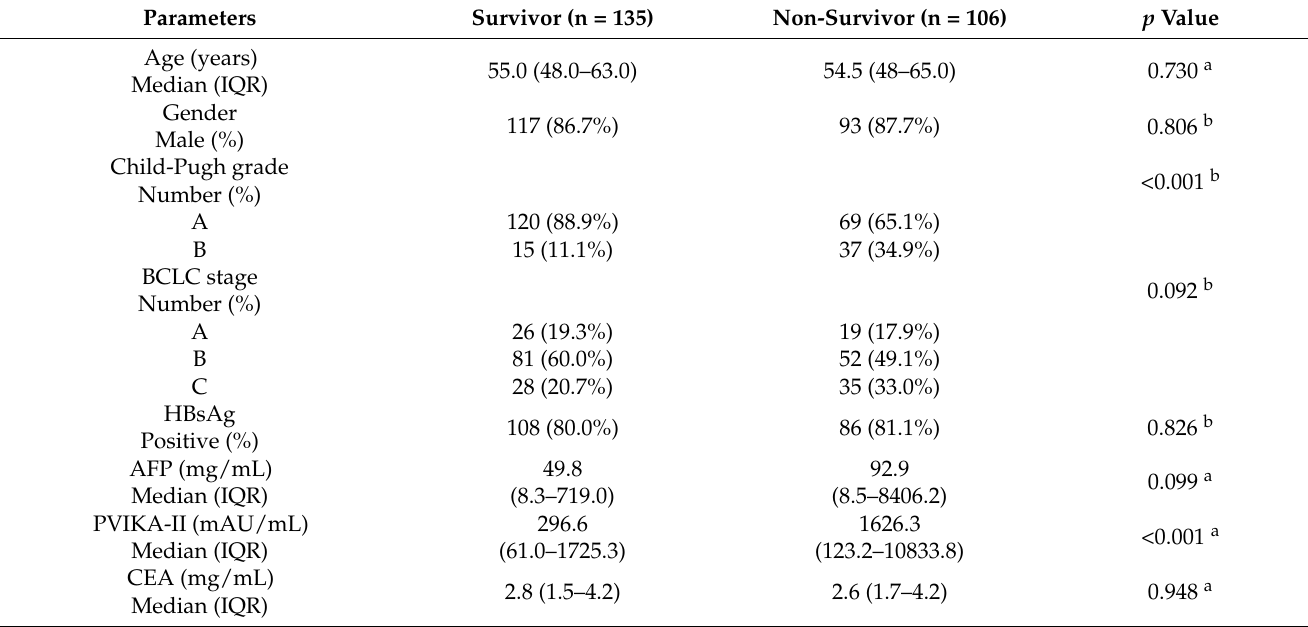
Table 3. Characteristics of HCC patients according to 3-year